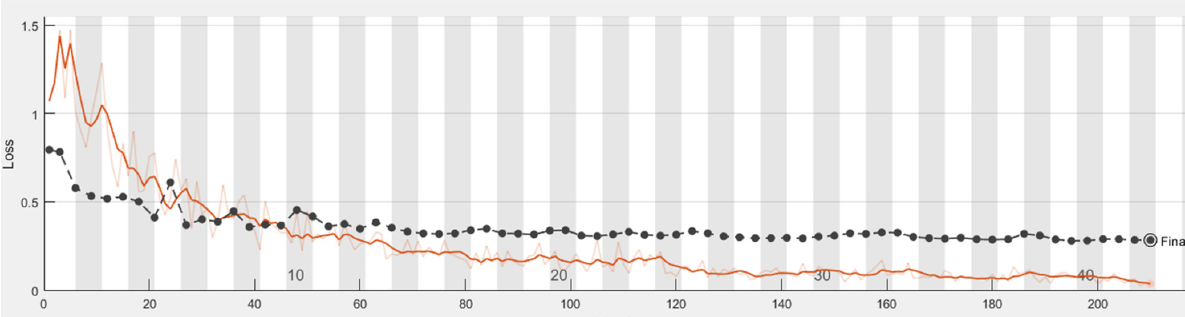
Sensors 2021 , 21 , x FOR PEER REVIEW Figure 12. Loss process of the model in classifying caries, with the orange line illustrating the loss of the training set.